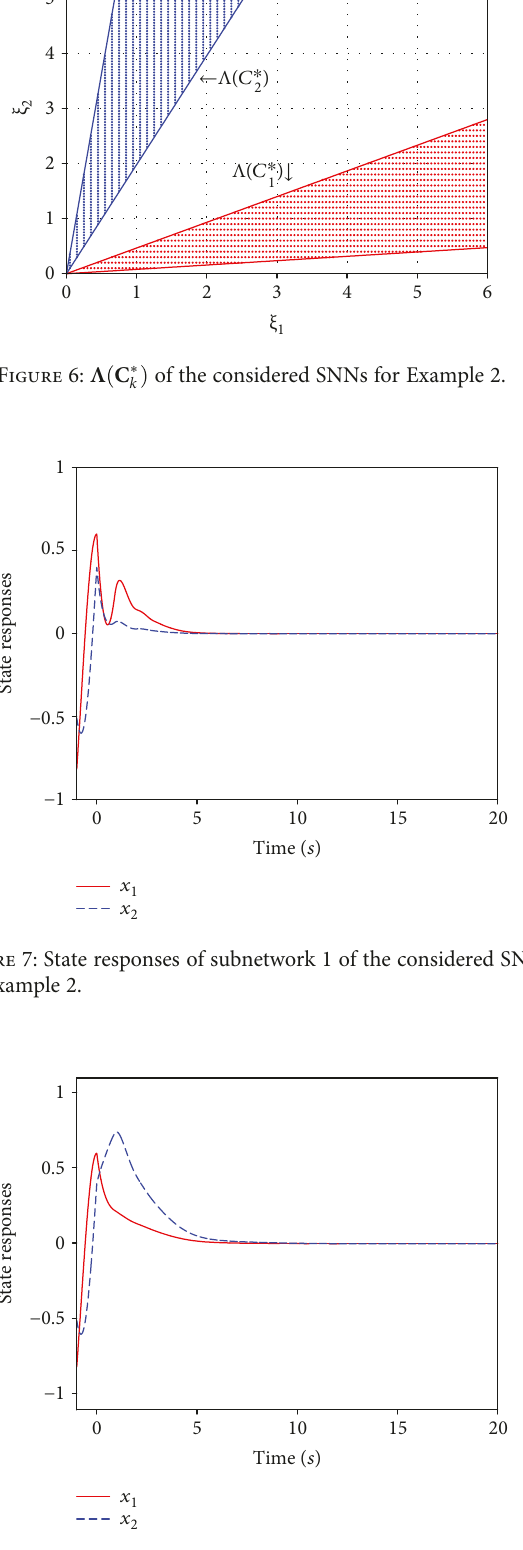
Figure 11: State norm response of the considered SNNs for Example 2 with average dwell time T